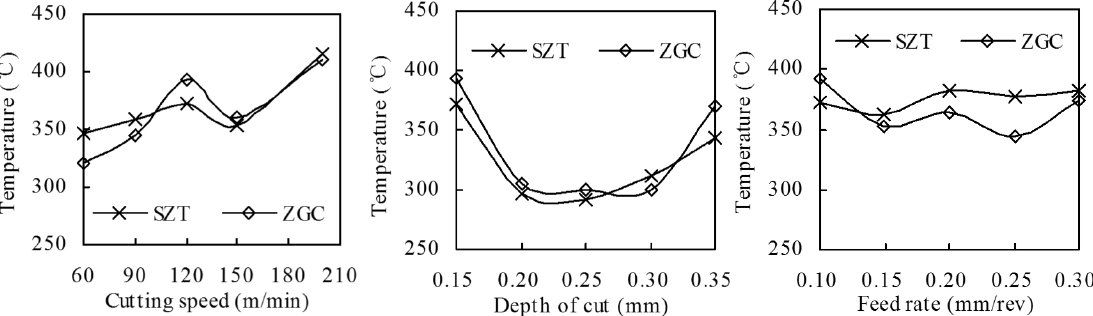
Figure 9. The highest cutting temperature at the tool–chip interface of ZrTiN-coated inserts at different cutting conditions.